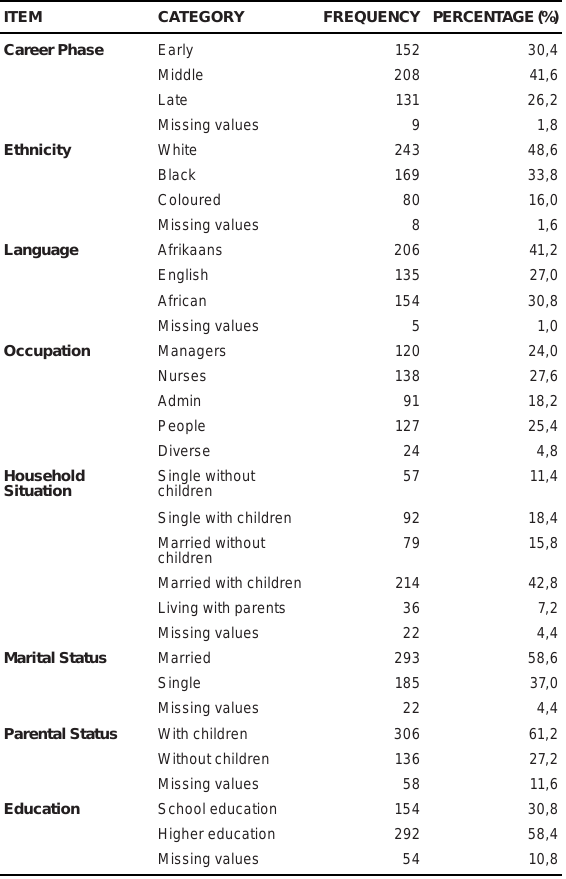
taBLe 1 Characteristics of the participants